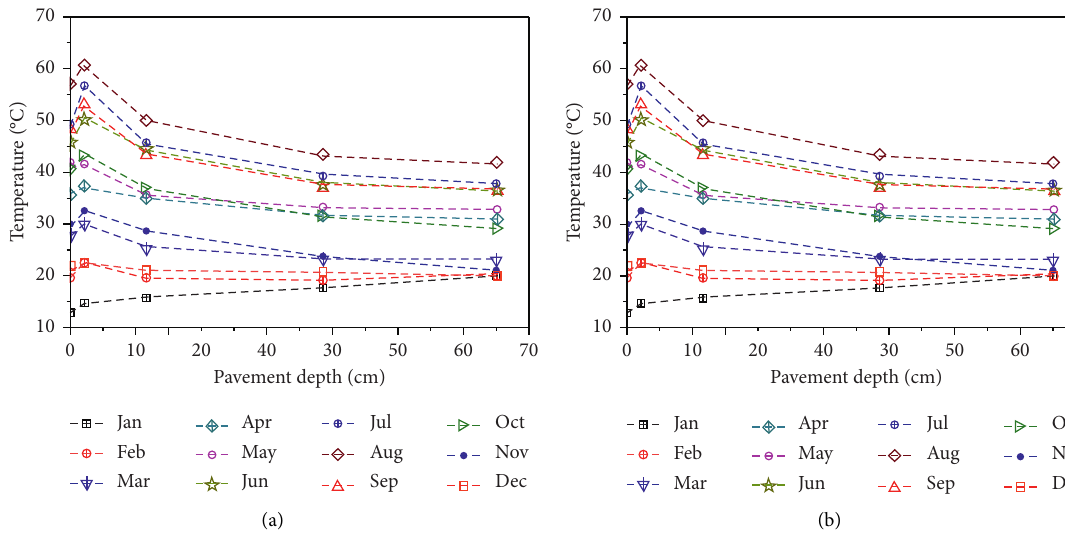
Figure 4: Average monthly temperature distribution of pavement: (a) Site 1. (b) Site